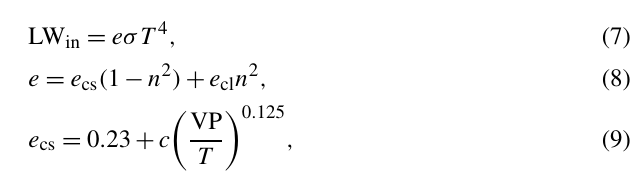
of cloud cover, air temperature, and humidity (Eqs. 8 and